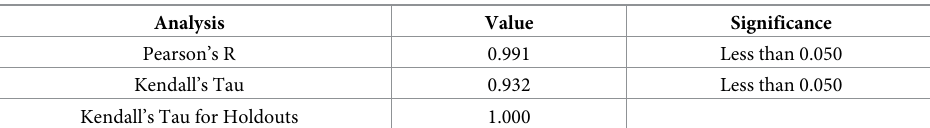
Table 7. Correlation.